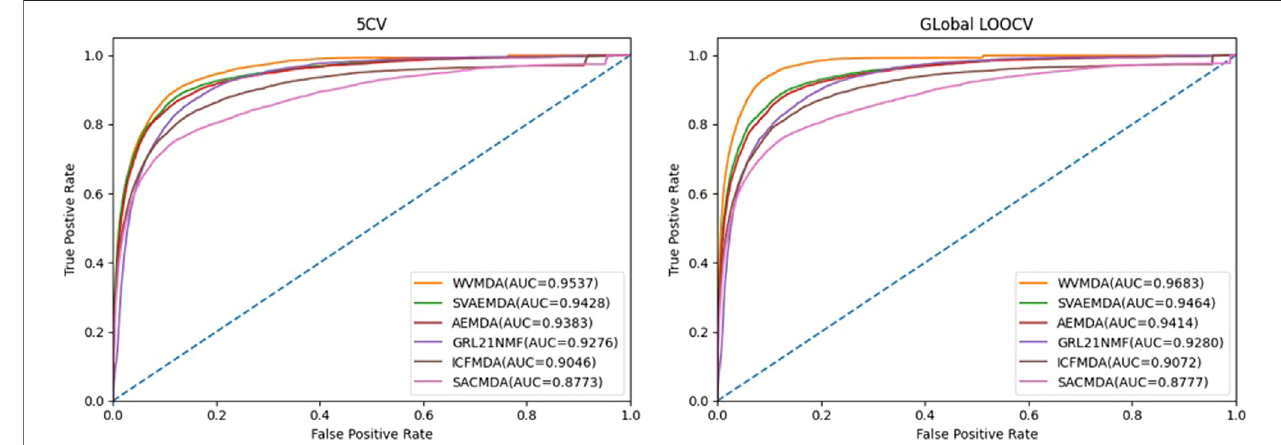
FIGURE 9 | ROC curve.